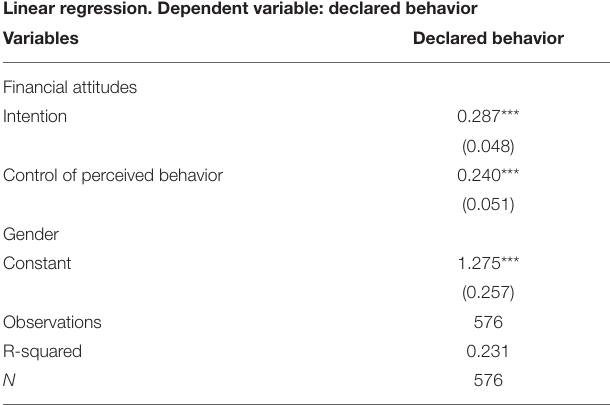
TABLE A2 | Linear regression for the variable declared behavior (robustness check). Linear regression. Dependent variable: declared